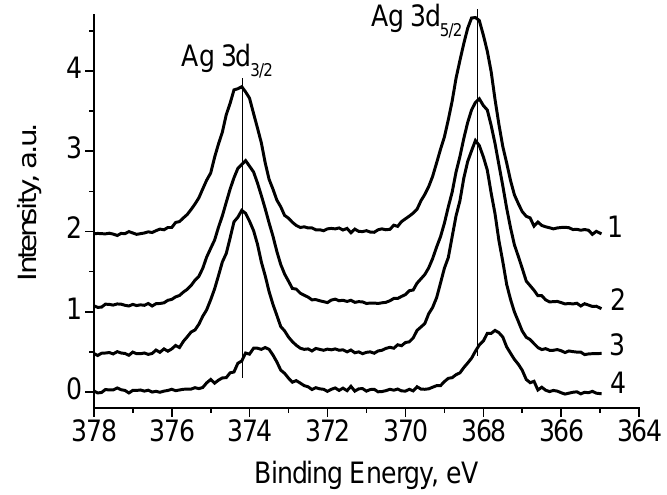
Figure 5. The Ag 3d photoelectron spectra of Ag black measured at different U b = +7 (1), − 7 (2), 0 V (3), ant difference spectrum (2)–(1). The spectra are corrected for U b.